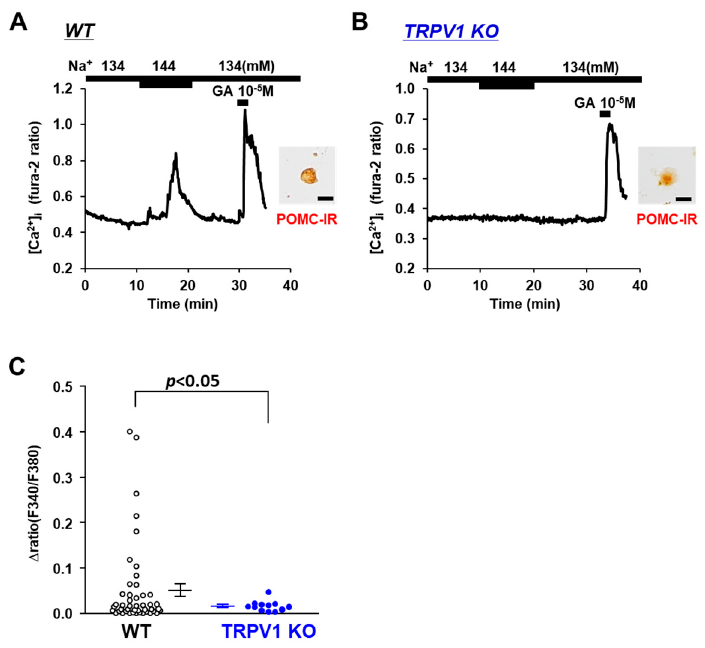
Figure 2. Increased extracellular [Na + ] failed to substantially increase [Ca 2+ ] i in single POMC neurons in ARC from Trpv1 KO mice. ( A , B ) Typical examples of [Ca 2+ ] i responses to [Na + ] increase and 10 -5 M glutamate (GA) in single ARC POMC neuron from wild-type mice ( A ) and TRPV1 KO mice ( B ). Scale bar is 20 μ m. ( C ) Average amplitude of [Ca 2+ ] i responses to increased extracellular [Na + ] ( Δ ratio) in POMC neurons. Data are presented as mean ± SEM. WT vs. KO determined by one-way ANOVA followed by the Bonferroni test.